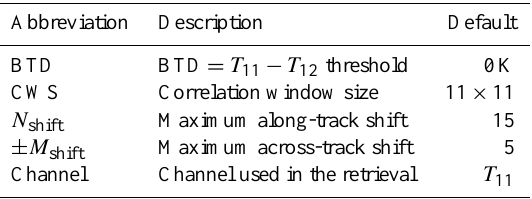
Table 1. Retrieval parameters, which need to be set prior to each retrieval. The default values are used in the results shown in this paper, unless otherwise